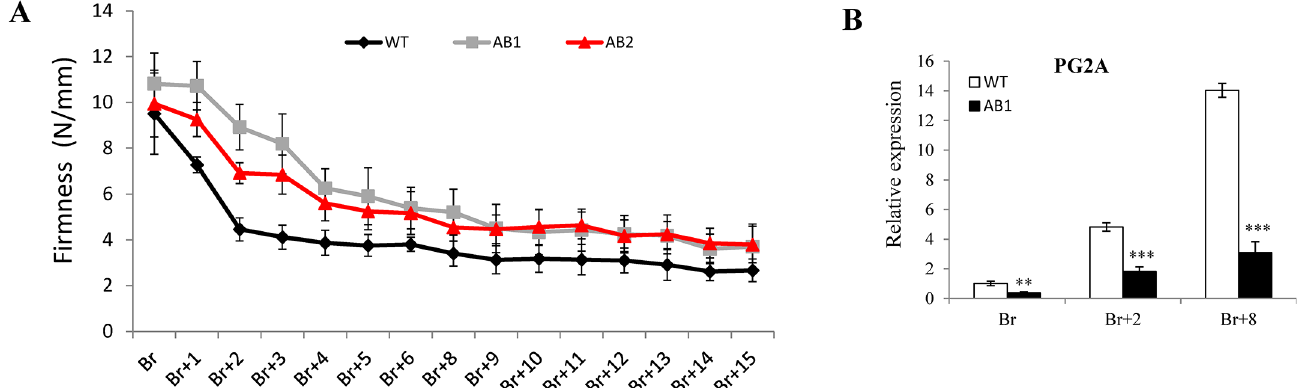
Fig 11. Altered firmness in SlARF2AB-RNAi fruits. (A) Firmness of wild-type and SlARF2AB-RNAi fruits. Fruits were harvested at breaker stage, kept at room temperate and firmness was measured day by day. A total of 15 fruits were used for each measurement and the error bars represent ± SD. AB1 = SlARF2AB-RNAi line 311; AB2 = SlARF2AB-RNAi line 223. (B) Quantitative RT-PCR relative expression of polygalacturonase gene PG2A at different ripening stages in SlARF2AB-RNAi and wild type fruits (breaker, Br; Br+2, 2 d post-breaker; Br+8, 8 d post-breaker). Relative mRNA levels in WT at the breaker (Br) stage were standardized to 1.0, referring to SlActin gene as internal control. Error bars represent ± SD of three biological replicates. Stars indicate a statistical significance using Student ’ s t-test: * p-value < 0.05, ** p-value < 0.01. ABL1 is SlARF2AB-RNAi line 311.